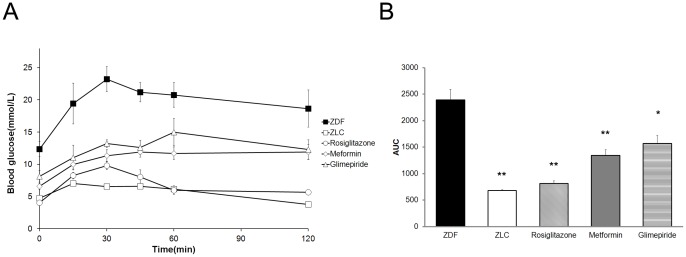
Effects of anti-diabetic drugs on the oral glucose tolerance test (OGTT) in ZDF rats.(A) OGTT in diabetic ZDF rat (▪, black squares), normal ZLC rats (□, white squares), rosiglitazone (○, white circles), metformin (◊, white diamonds) and glimepiride (Δ, white triangles)-treated diabetic ZDF rats. (B) The glucose area under the curve (AUC) during the course of the experiments was calculated. * p<0.05, ** p<0.01.